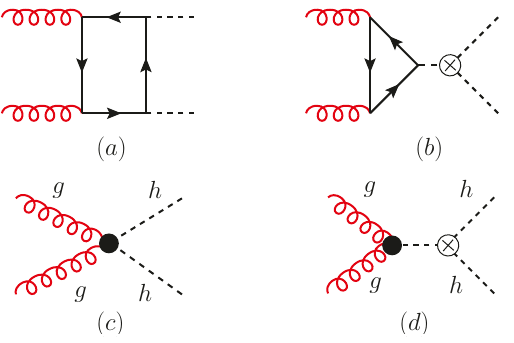
Figure 1 . The LO Feynman diagrams of the process gg ! hh with full top-quark mass dependence ((cid:12)rst row) and in the in(cid:12)nite top-quark mass limit (second row). the single-Higgs data have been set in the range (cid:21)